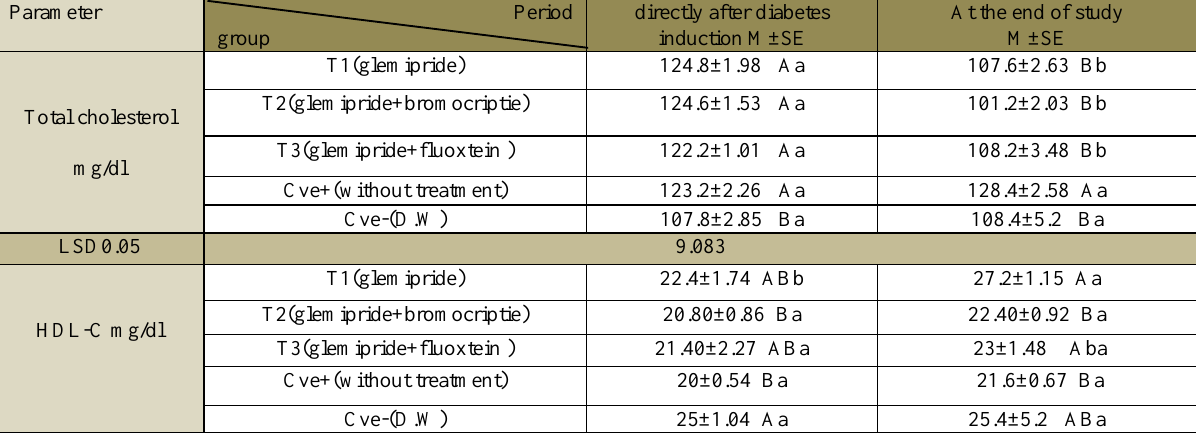
Table,3: lipid profile mg/dl in induced diabetic rabbit groups dosed orally for two months with glimepride ,bromocriptine and fluoxtein